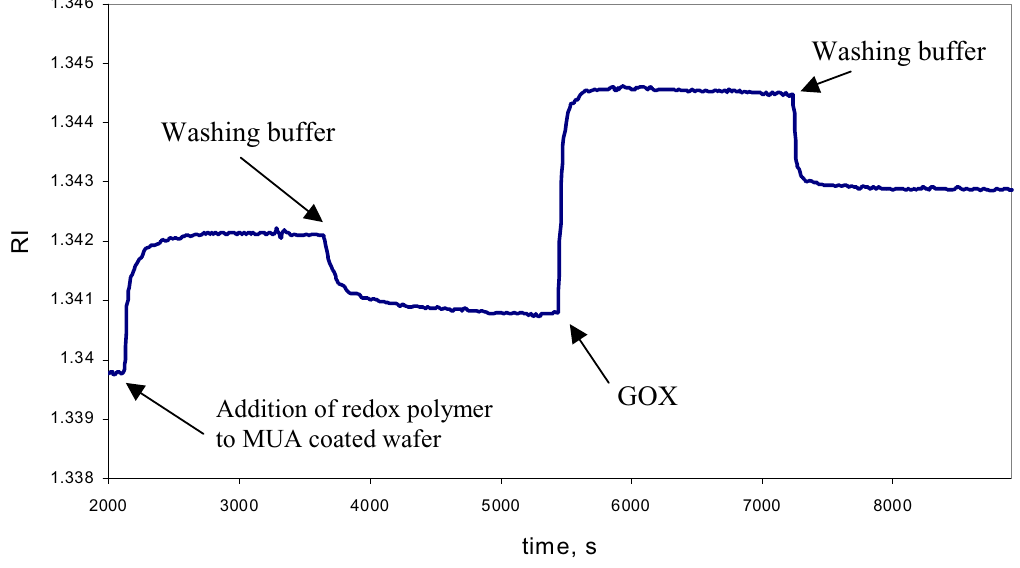
Figure 3 . Changes in refractive index with time as measured by SPR during the assembly of a nanocomposite thin film consisting of MUA and one RP/GOX bilayers. The concentrations of RP and GOX were 10 mg/mL in PBS, flow rate 80 µ